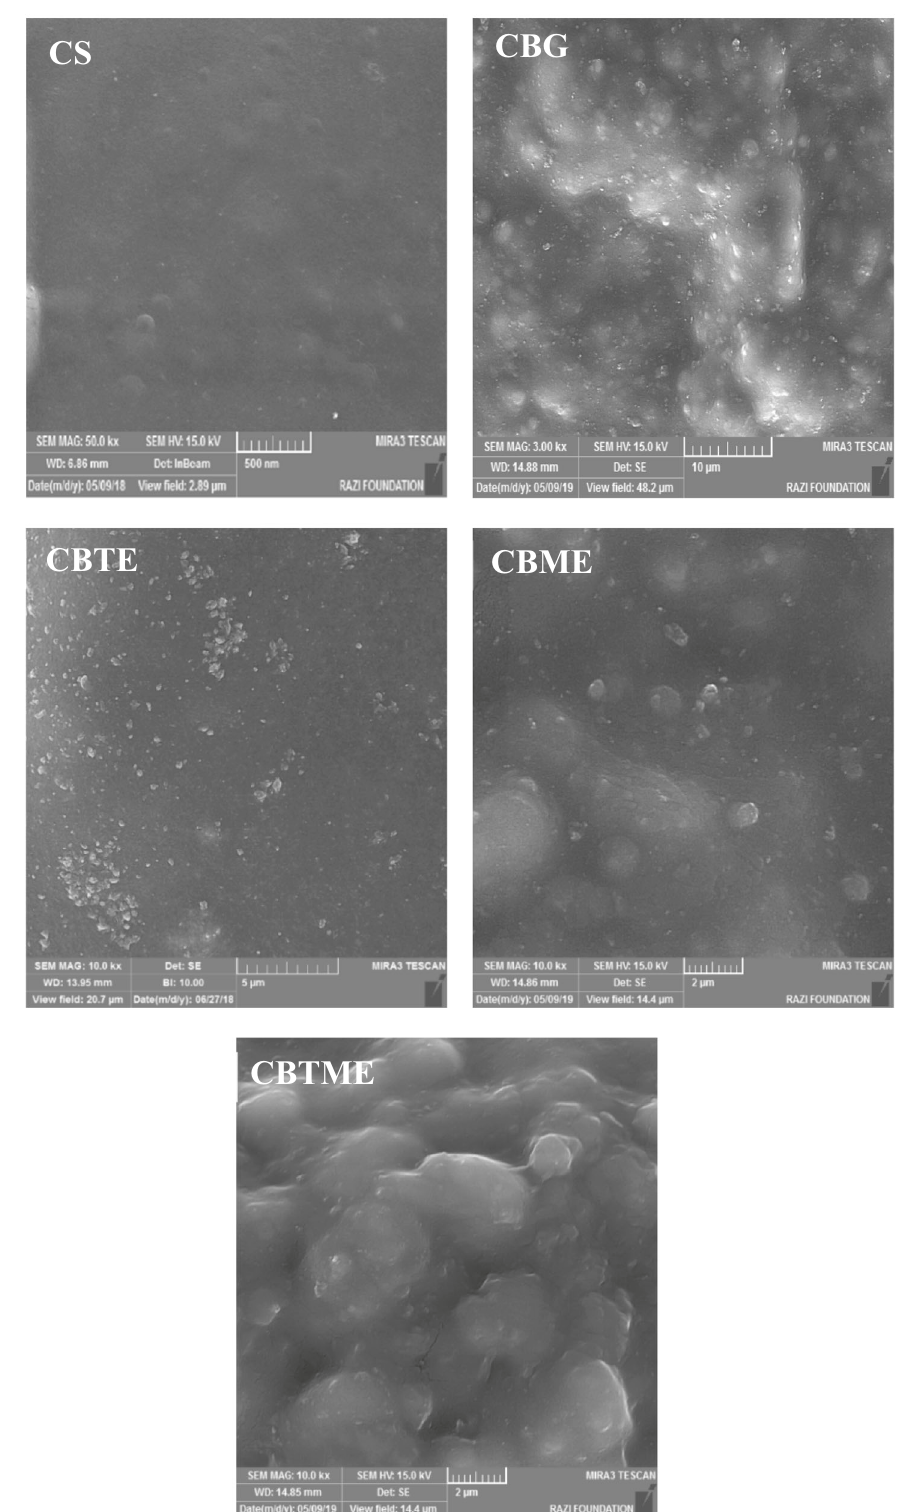
Fig. 2 FE-SEM images of CS, CBG, CBTE, CBME and CBTME coatings (SEM magni fi cation in all images is 10.0